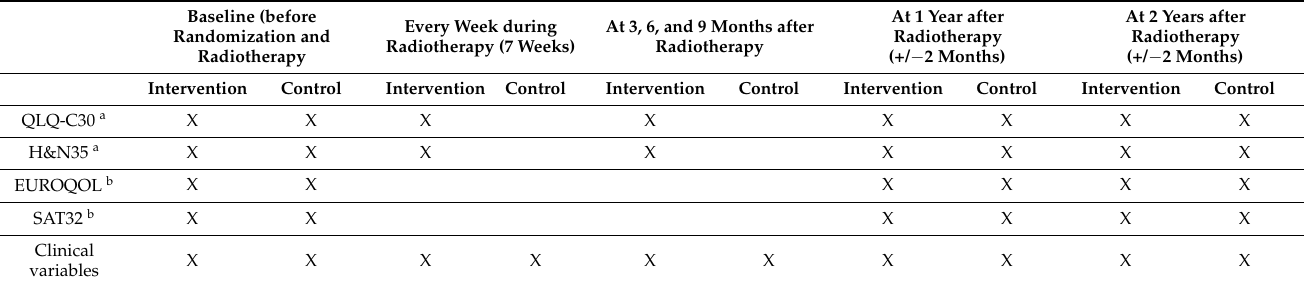
Table 1. Follow-up summary